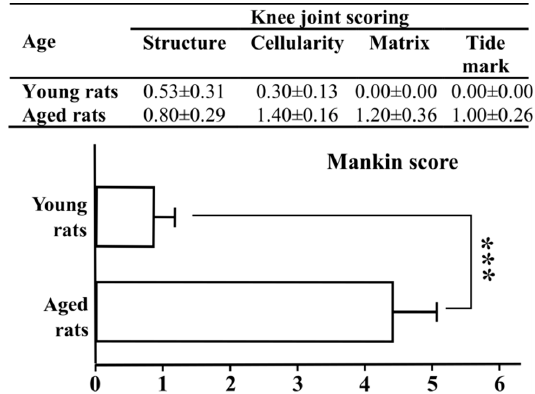
Figure 5. Comparison of knee joint scores between young rats and aged rats. Rats on normal control diet at age of 26 weeks (young rats, n = 12) and 48 weeks (aged rats, n = 10) were sacrificed and knee joints were processed to pathological slide preparation stained with Safranin-O. The criteria of Mankin score were used to evaluate articular cartilage and then summed into mean ± SE presented in the bar chart. Mann–Whitney U test was used to analyzed statistical differences between young rats and aged rats as which asterisk *** shows significance at p < 0.001.